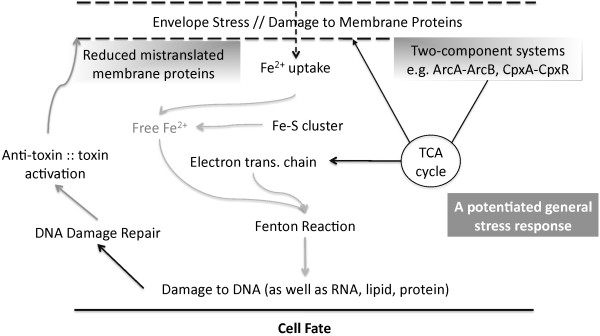
Schematic summary of cellular signaling pathways leading to reduced reactive oxygen species production and increased fitness in ΔybeY bacteria during HU exposure. Results suggest that complex molecular changes that are mediated by YbeY action determine the cell fate during HU stress.